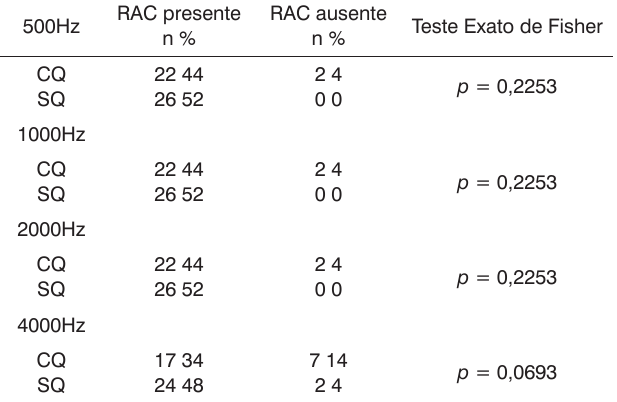
Tabela 1. Análise comparativa entre os grupos CQ e SQ quanto ao RAC na orelha do lado